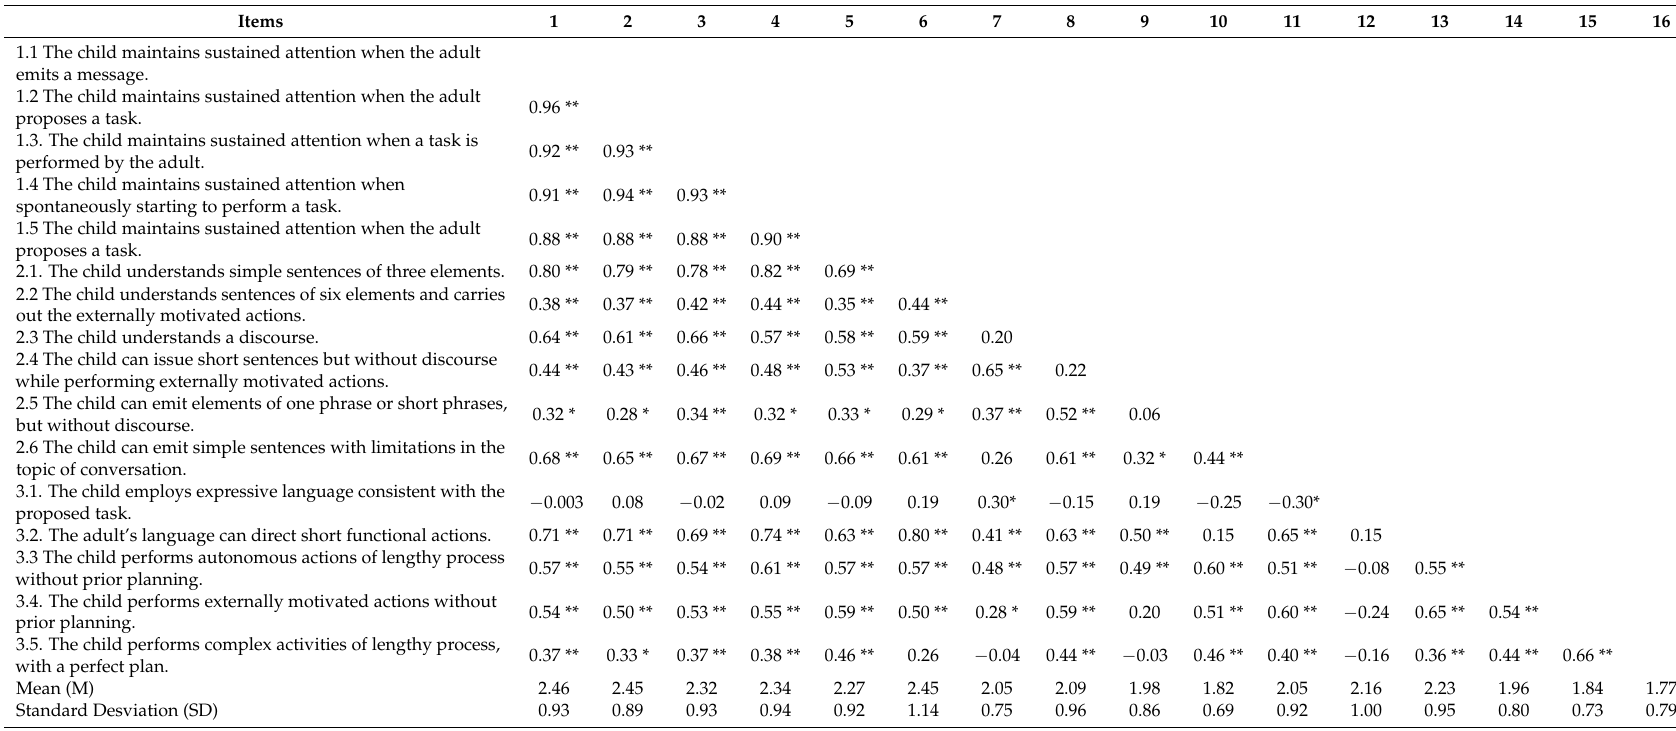
Table 2. Inter-element Correlation Matrix and Means and Standard Deviations of the s cale of assessment of metacognitive precursors (SMPMS).